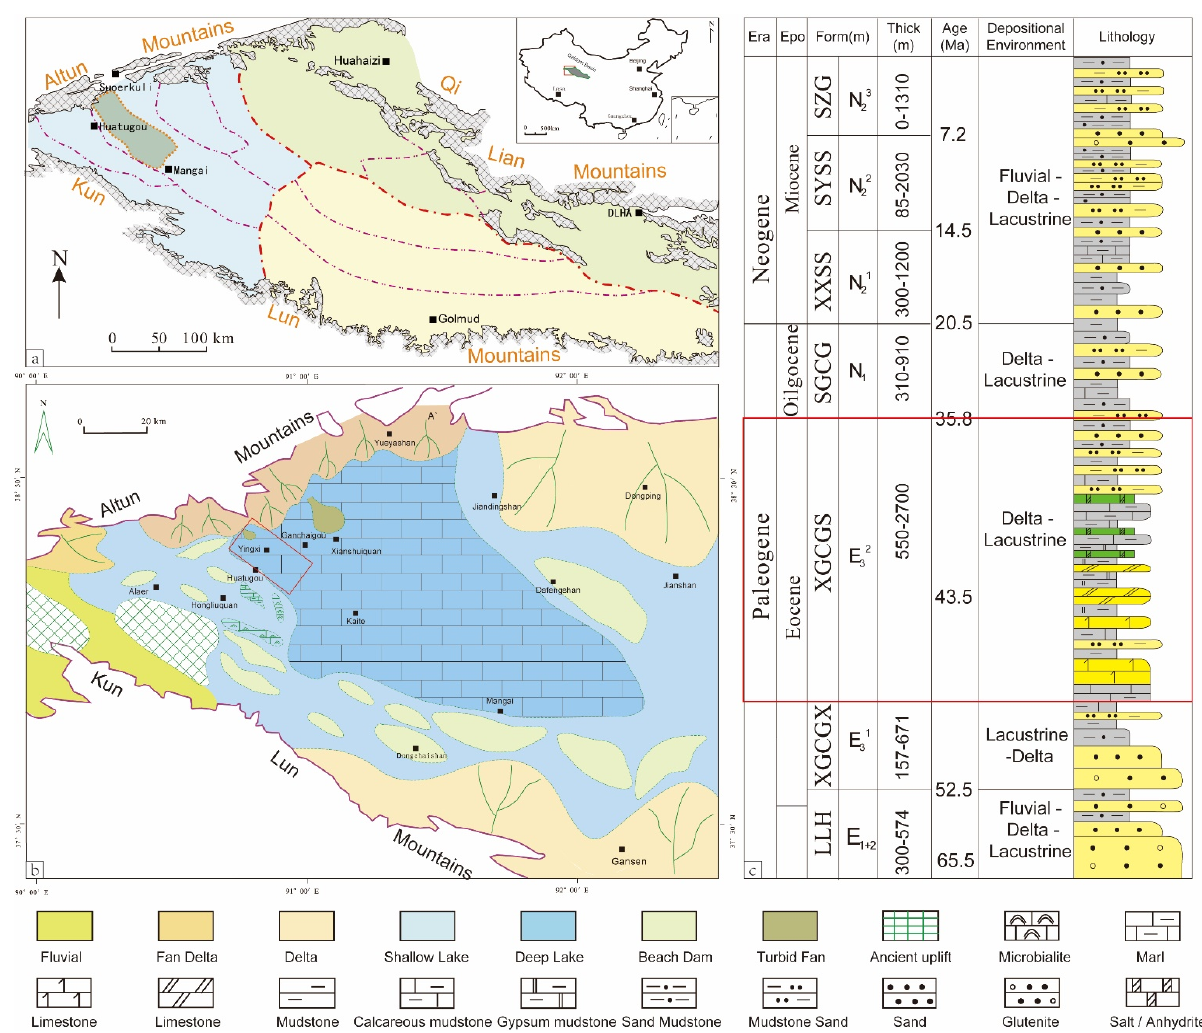
Figure 1. Tectonic location and topography of the study area in the Western Qaidam Basin: ( a ) tectonic division of the Qaidam Basin; ( b ) topography of the study site; and ( c ) comprehensive histogram of strata and lithology. Table 1. Stratigraphy division of Cenozoic strata in the Qaidam